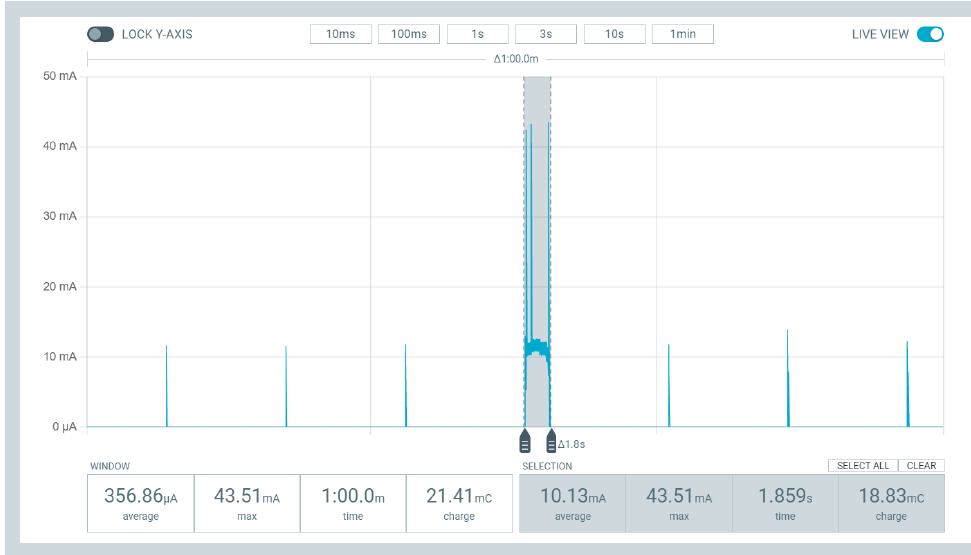
Figure 17. Example of sensor modules’ consumption with DROWSIER